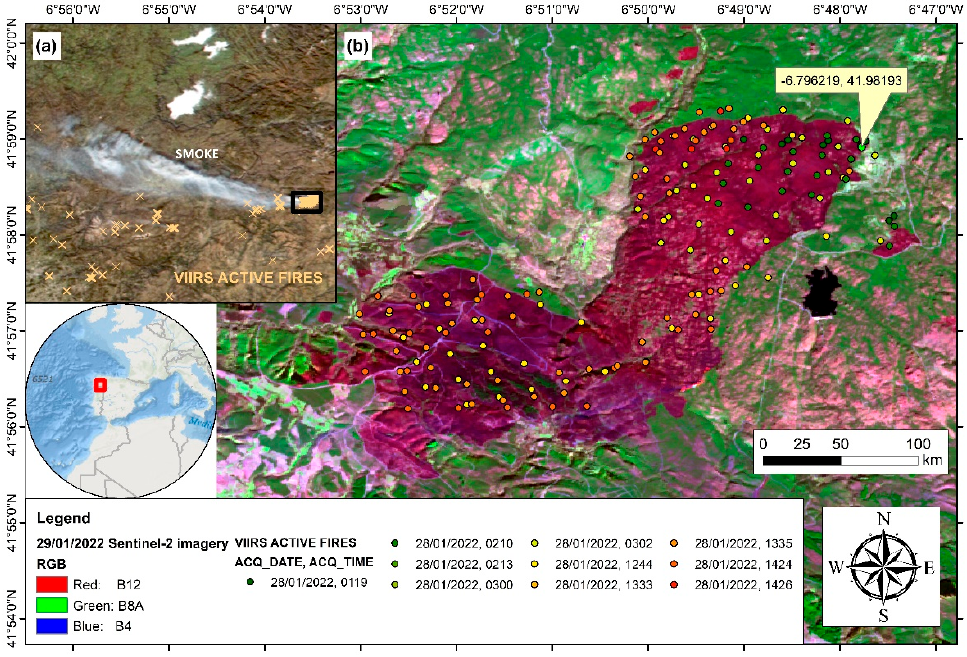
Figure 5. Fire characteristics on 28th January 2022: ( a ) image of the VIIRS active fires and smoke plume; ( b ) VIIRS active fires along the burned area.